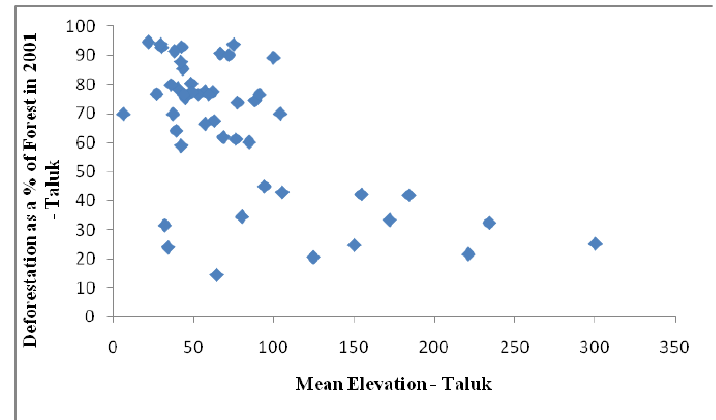
Figure 10b. Relationship between mean elevation and the distribution of deforestation as a percentage of the forest area existing in 2001, for